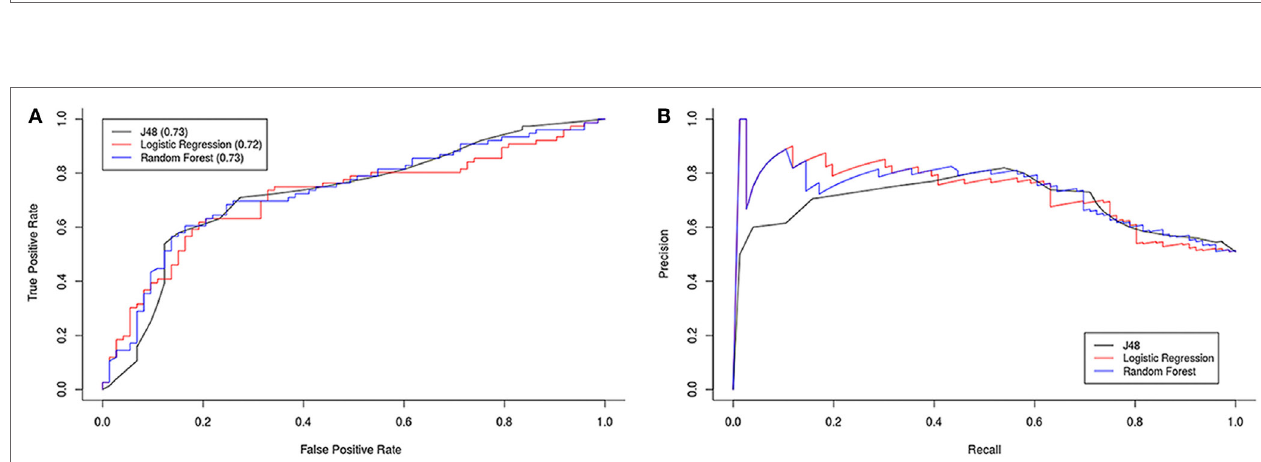
FigUre 7 | ROC (a) and precision/recall (b) graphs for all three classification